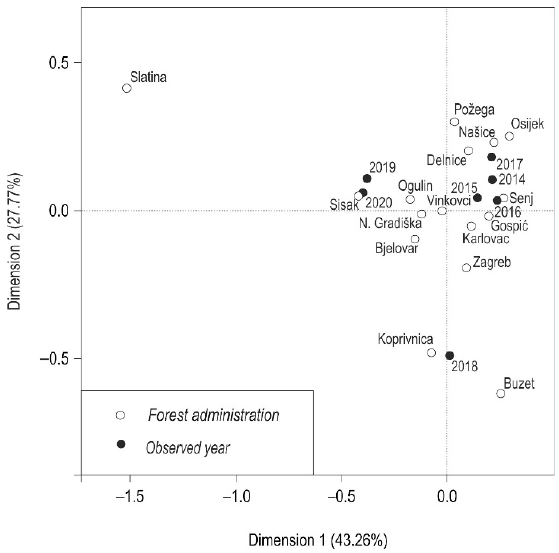
Figure 4. Correspondence analysis map for injuries related to felled and processed wood. Analysis of variance was used to test the differences between three defined groups.